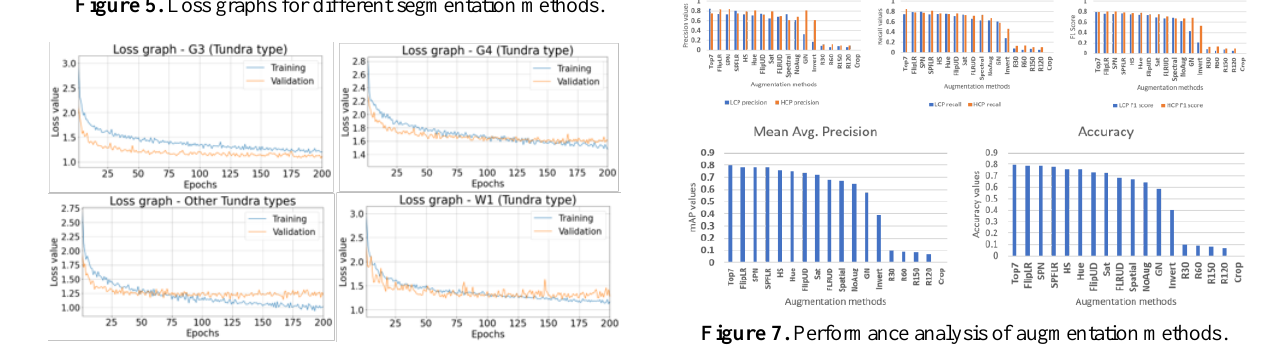
Figure 5. Loss graphs for different segmentation methods.